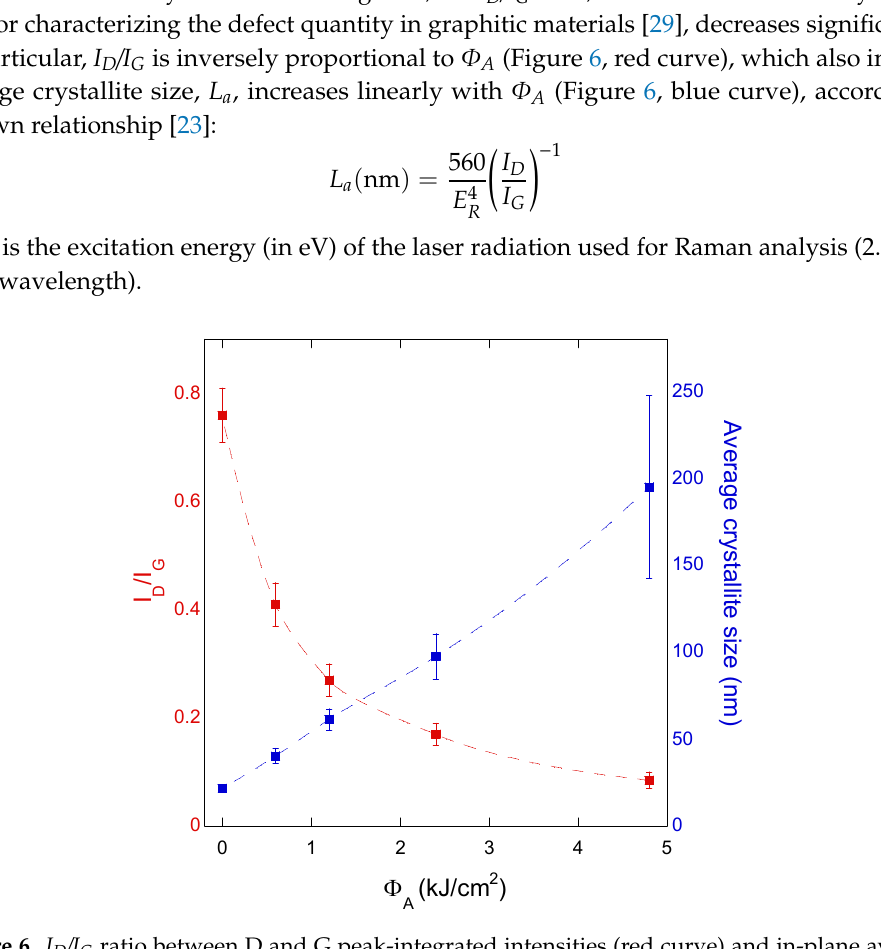
Figure 6. I D / I G ratio between D and G peak-integrated intensities (red curve) and in-plane average crystallite size (blue curve) as a function of the total accumulated laser fluence. The average crystallite size at a given Φ A value was obtained from Equation (2) by substituting the corresponding I D / I G ratio. The large error bar of the average crystallite size at the highest Φ A value (4.8 kJ / cm 2 ) is due to the high uncertainty on the integrated intensity of the D band, which is almost indistinguishable from the baseline (see Figure 5).